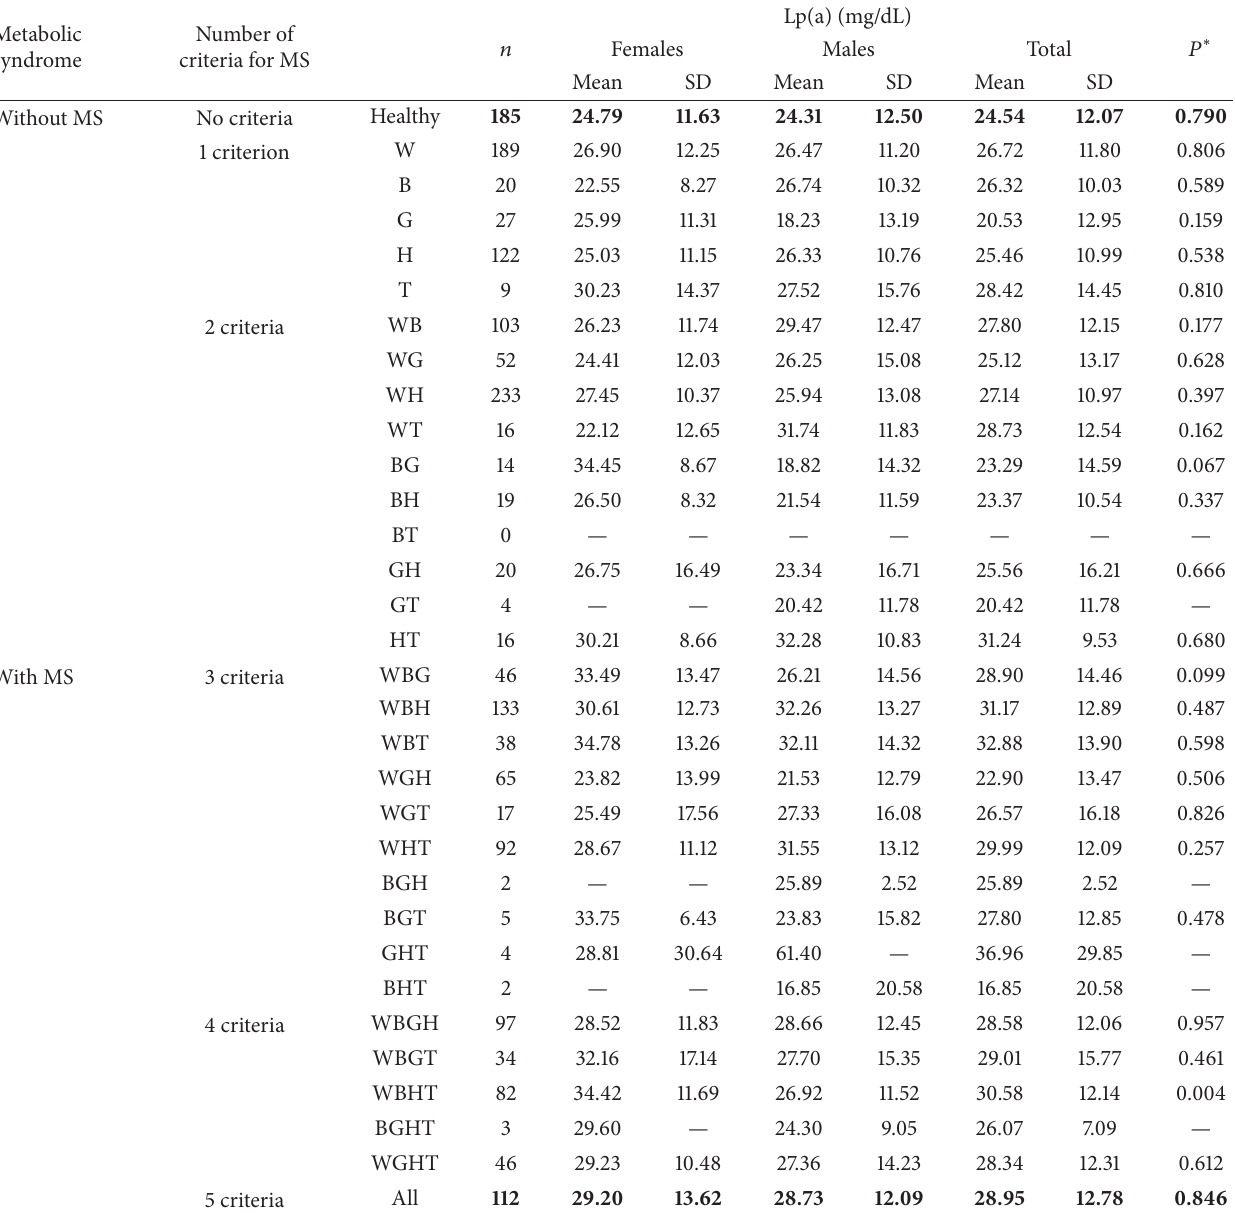
Table 5: Serum Lp(a) concentration in the general population and by gender according to specific diagnostic combinations for the metabolic syndrome. The Maracaibo City Metabolic Syndrome Prevalence Study, 2013. Metabolic